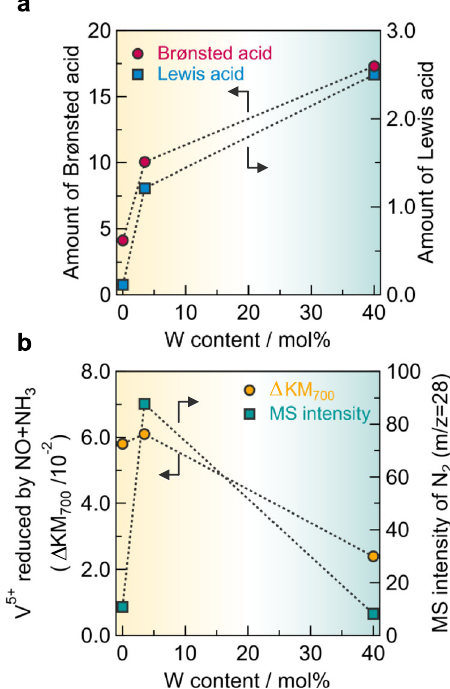
Fig. 7 Effect of tungsten on acid and redox properties. a Amount of Lewis and Brønsted acid sites as a function of W content. The amount of both acid sites was observed from the area of initial IR spectra after ammonia adsorption (spectra at 0 s in Fig. 6a – c). b Amount of V 5 + reduced by NO + NH 3 and MS intensity of N 2 produced as a function of W content. The amount of V 5 + reduced was determined from the change in the Kubelka – Munk unit at λ = 700 nm ( Δ KM 700 ) under NO (500 ppm) + NH 3 (500 ppm) fl owing (1500 s) at 150 °C under a dry atmosphere shown in Supplementary Figs. 7 and